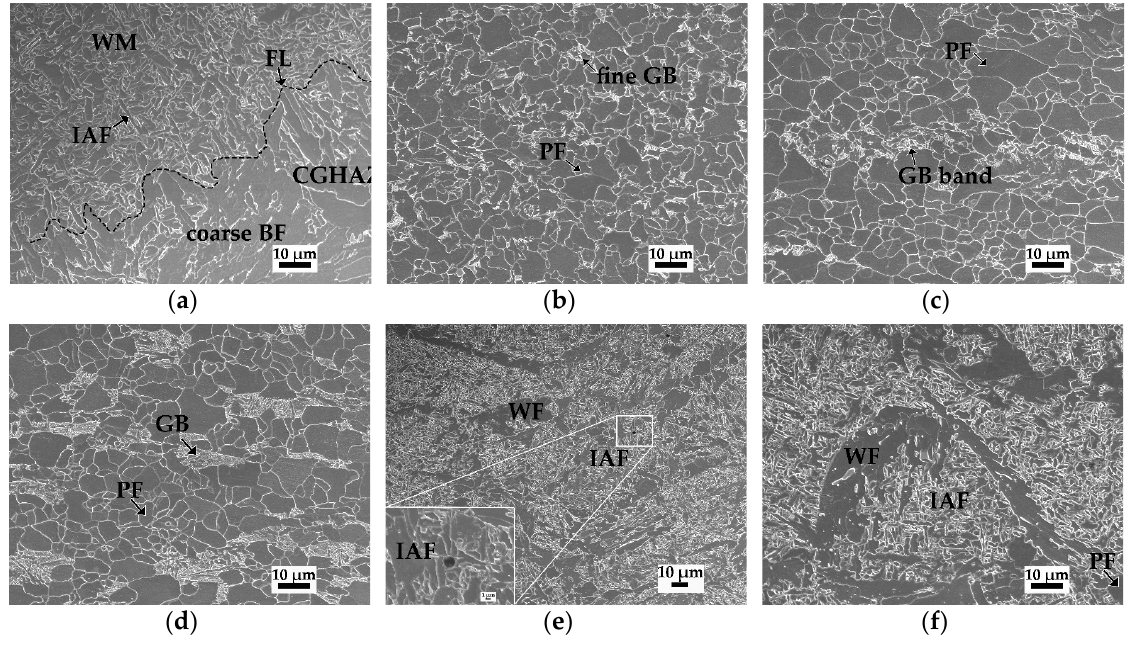
Figure 4. SEM images of the welded joint. ( a ) FL; ( b ) FGHAZ; ( c ) ICHAZ; ( d ) SCHAZ; ( e ) weld center at 2 mm away from the outside weld surface; ( f ) weld center in midthickness. The microstructures of WM primarily include IAF, a small amount of widmanstat- ten ferrite (WF) and GB, where PF is also occasionally presented in the weld root in the midthickness. Ti-containing complex oxide inclusions in the WM promote the forma- tion of IAF with a radial distribution [17]. Research indicates that the IAF is generally associated with high strength and toughness because of the interlocked and fine-grained structures [18,19]. However, the Charpy impact properties would deteriorate when PF and WF microstructures appear [5,18,20]. Therefore, the values of Charpy impact energy at the weld center near the outer surface are much higher than those of the weld root in the midthickness with higher volume fractions of PF and WF (Figure 4e,f) [21]. Figure 5 presents the distribution and morphology of MA constituents in different regions. The average size and volume fraction of MA constituents in different regions are given in Table 2. Due to the thickness of the investigated steel, the cooling rate and peak temperature are quite different in different regions of the welded joint, resulting in different MA volume fractions and morphologies [6,22]. MA constituents in CGHAZ are slender along the lath boundaries of BF (Figure 5b), and the maximum width and length values of MA constituents can reach 5.2 µ m and 12.0 µ m, respectively. The MA constituents in CGHAZ are larger and exhibit a higher volume fraction with elongated block shapes compared with other positions in the welded joint due to the high peak temperature and the low cooling rate of CGHAZ, which would be the zone with the lowest toughness and highest hardness [6]. with CGHAZ, where the majority of the MA is blocky with different sizes, which were formed at the triple junction, grain boundary and the inner portions of the ferrite grains (Figure 5c). In ICHAZ, there is more residual austenite, which always concentrates on the prior austenite grain boundaries, transforming into MA constituents during the cooling stage due to carbon enrichment, as shown in Figure